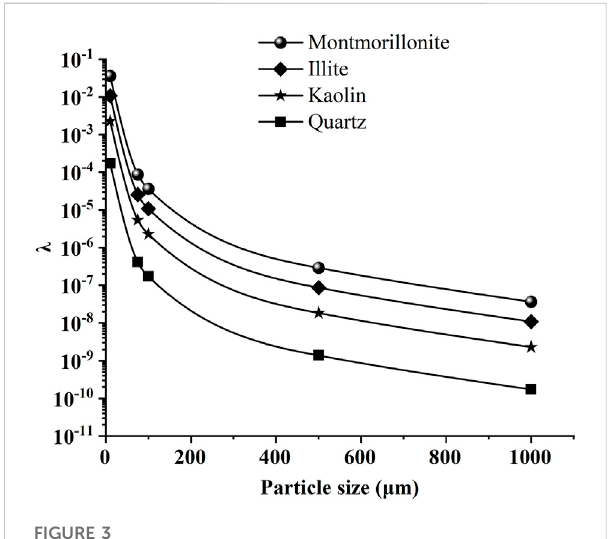
FIGURE 3 Relationship curve of the particle size and λ of the four components.